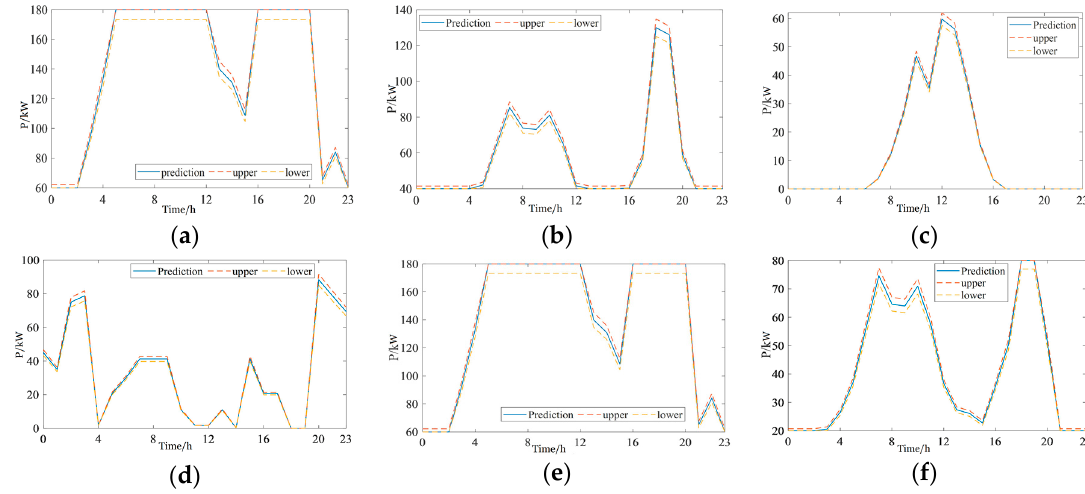
Figure 13. The optimal output of HD1 ( a ), The optimal output of FT1 ( b ), The optimal output of PV ( c ), The optimal output of WT ( d ), The optimal output of HD2 ( e ), The optimal output of FT2 ( f ).